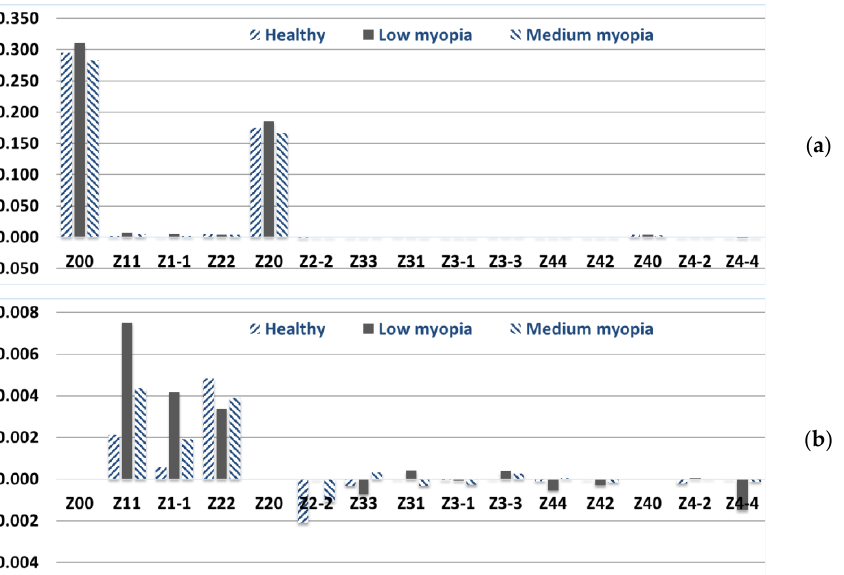
Figure 1. Zernike polynomial weight values for total wave aberration in healthy people and people with low/medium corneal myopia: ( a ) first 15 Zernike basis functions, ( b ) Zernike basis functions other than ( n , 0).